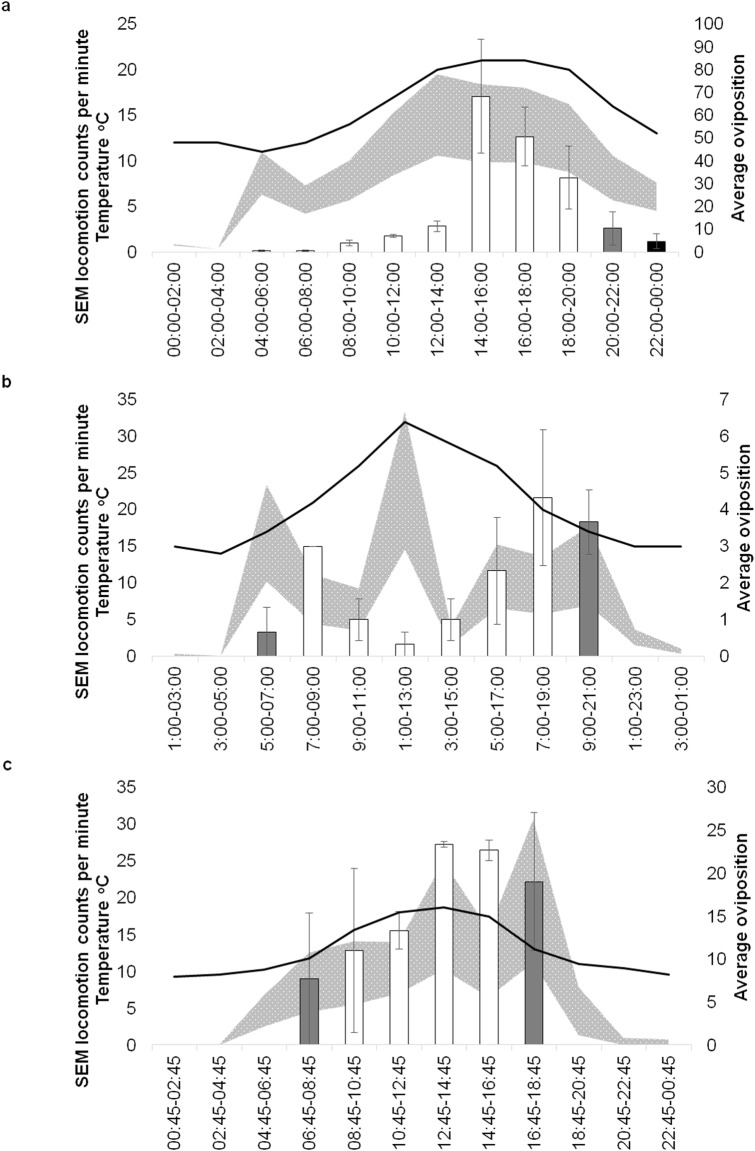
Mean locomotion counts/minute of mix sex groups in relation to average oviposition.Standard error of mean range of locomotion (counts per minute) of mix sex groups (grey area) in relation to average oviposition (+SE) (bars) and temperature (dash grey line) in the laboratory. Collected under recreated (a) June, (b) August and (c) October conditions. Light is indicated by the colour of average counts bars: Black in darkness, grey in half-light and white in full-light. Oviposition was assessed during the light phase (04:00–00:00 under June conditions, 05:00–21:00 under August and 06:45–18:45 under October).